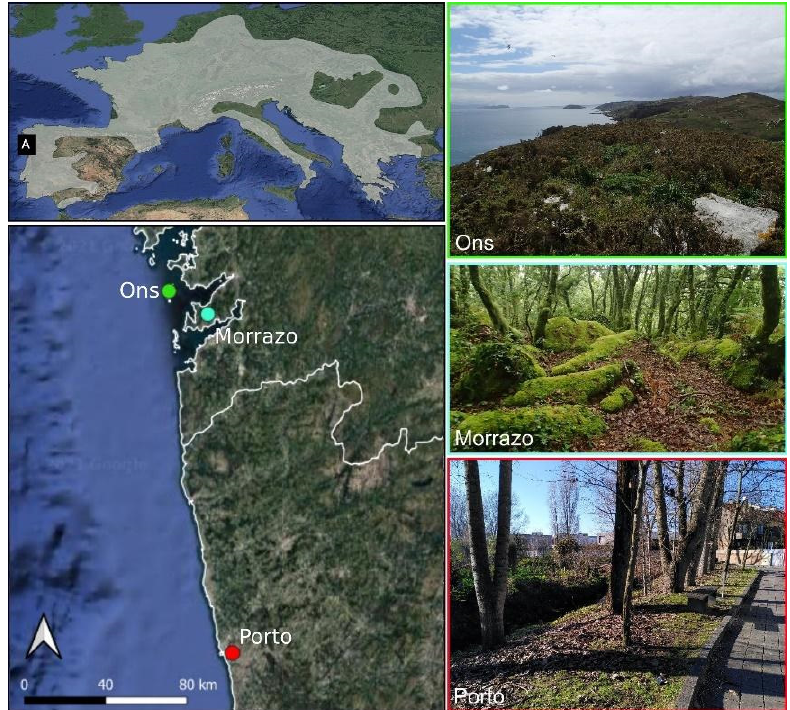
Figure 1. Maps include the species distribution of Salamandra salamandra , our study region in the northwest Iberian Peninsula, and photos illustrating the habitats found within the three sampled regions of Ons, Morrazo, and Porto.